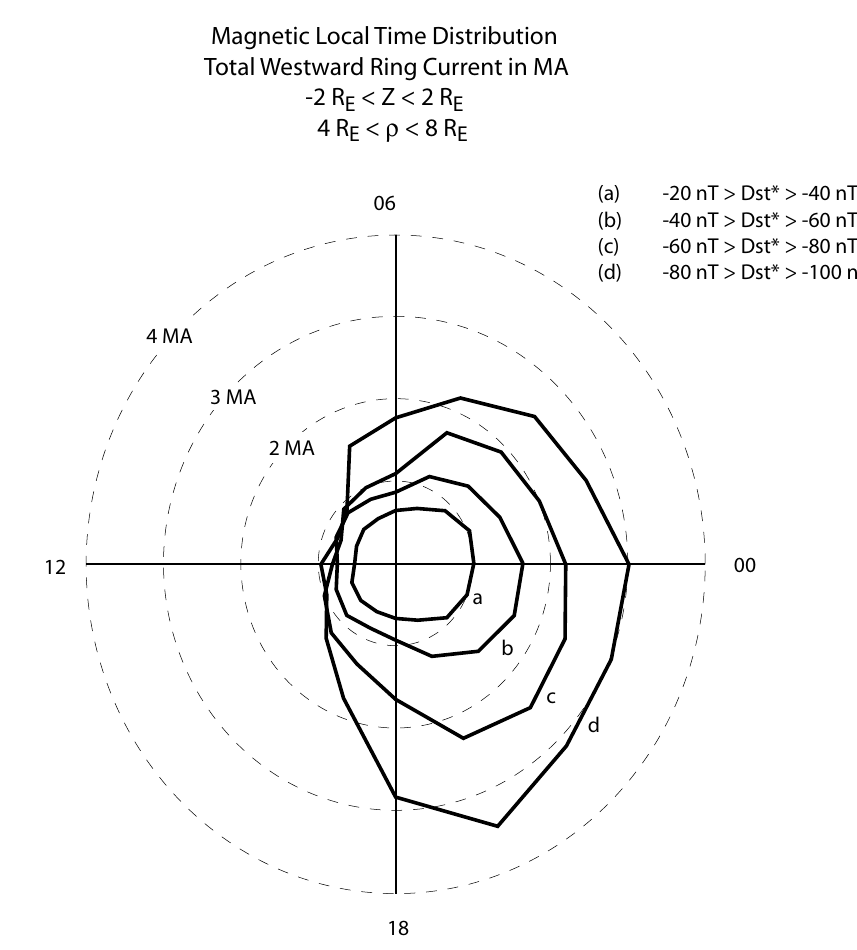
Fig. 9. Polar plot of the total westward flowing ring current obtained by integrating the current density from 4 to 8 R E in ρ and from − 2 to 2 in Z and plotting versus local time for each of the four ranges in D st *.